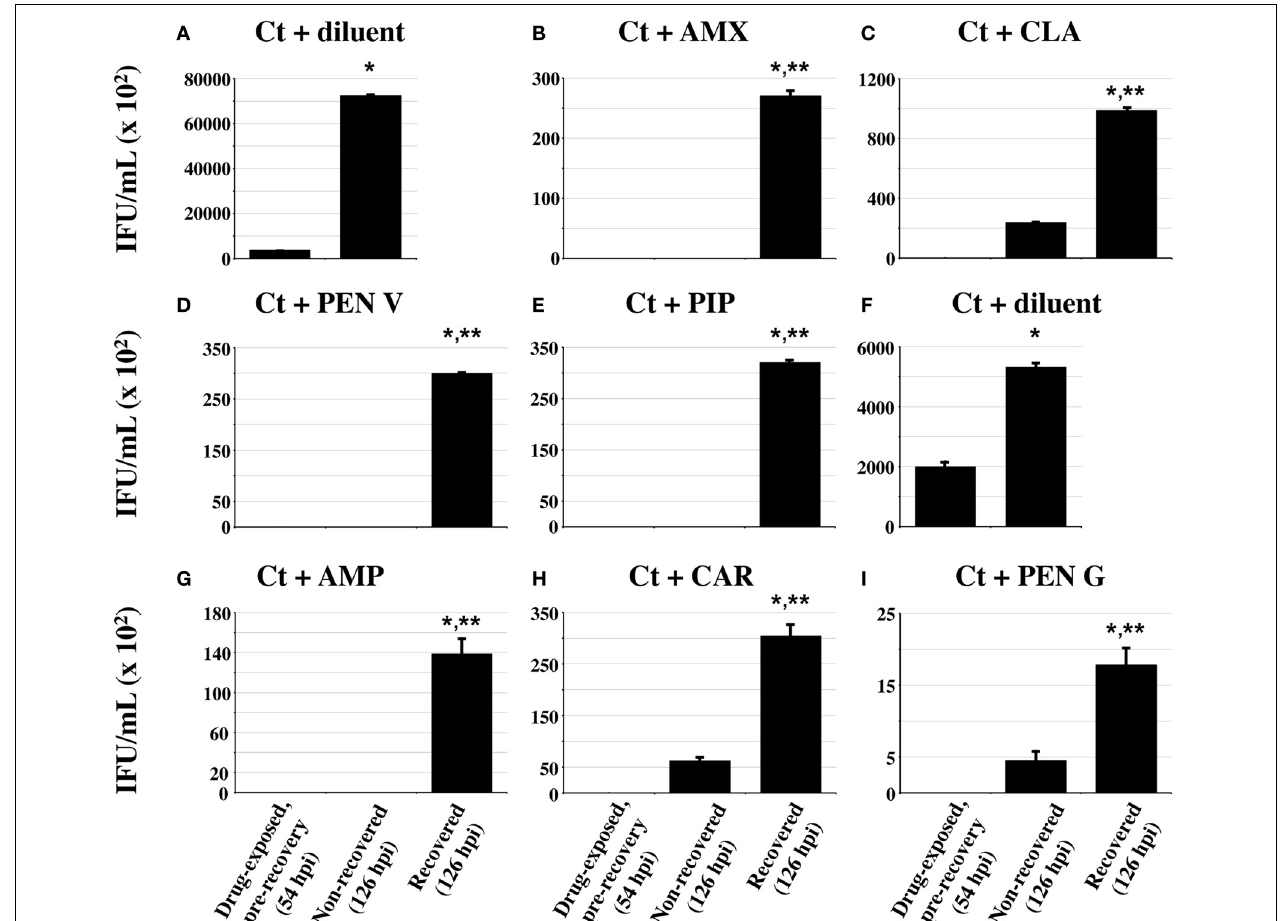
FIGURE 5 | Penicillin-induced stress/persistence is reversible. Replicate cultures of HeLa cells were infected and antibiotic-exposed at concentrations 10-fold higher than the MBC for each drug ( Table 1 ) using the timing scheme described in Figure 3 . At 30h post-antibiotic addition (54hpi total), one set of cultures was harvested for “pre-recovery” EB titration as in Figure 3 . Duplicate antibiotic-exposed and control cultures were washed, refed with either antibiotic-replete (non-recovered samples) or antibiotic-deficient (recovered samples) growth medium and allowed to recover for 3 additional days (a total of 126 hpi). These cultures were then processed for EB titration.